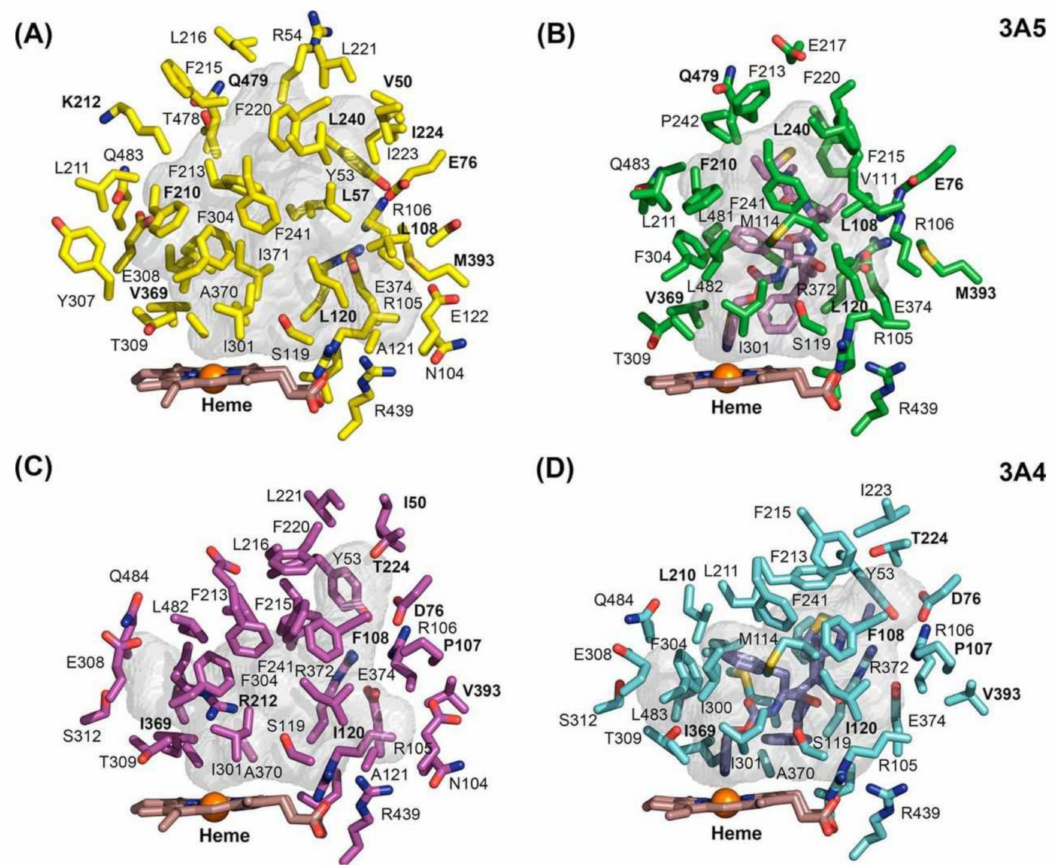
Figure 2. The active site cavities (grey shapes) of CYP3A5 and CYP3A4 in an unbound and ritonavir- bound state. ( A ) Active site cavity of CYP3A5 (amino acid (aa) side chains in yellow). ( B ) Active site cavity of CYP3A5 bound to ritonavir (aa side chains in green). ( C ) Active site cavity of CYP3A4 (aa side chains in magenta). ( D ) Active site cavity of CYP3A4 bound to ritonavir (aa side chains in cyan). Heteroatom colors are nitrogen (blue), oxygen (red), iron (orange), and sulfur (dark yellow). The active site of ritonavir-bound CYP3A5 is narrower and smaller in size compared to that of CYP3A4, which is adapting its width and height toward the ritonavir molecule. The thiazole group of ritonavir (pink purple in panel ( B ), blue purple in panel ( D )) shows an equally tight association with the heme iron in both enzymes. This figure was reproduced with permission from